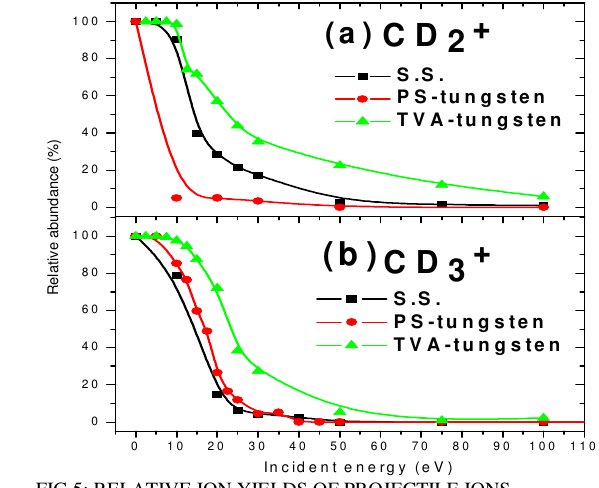
FIG.5: RELATIVE ION YIELDS OF PROJECTILE IONS AGAINST INCIDENT ENERGY FOR (A) CD 2+ AND (B) CD 3+ TVA tungsten surface in comparison to other S.S. at 15 eV to a maximum of about 20 times at 50 eV). As translational energy may transform to